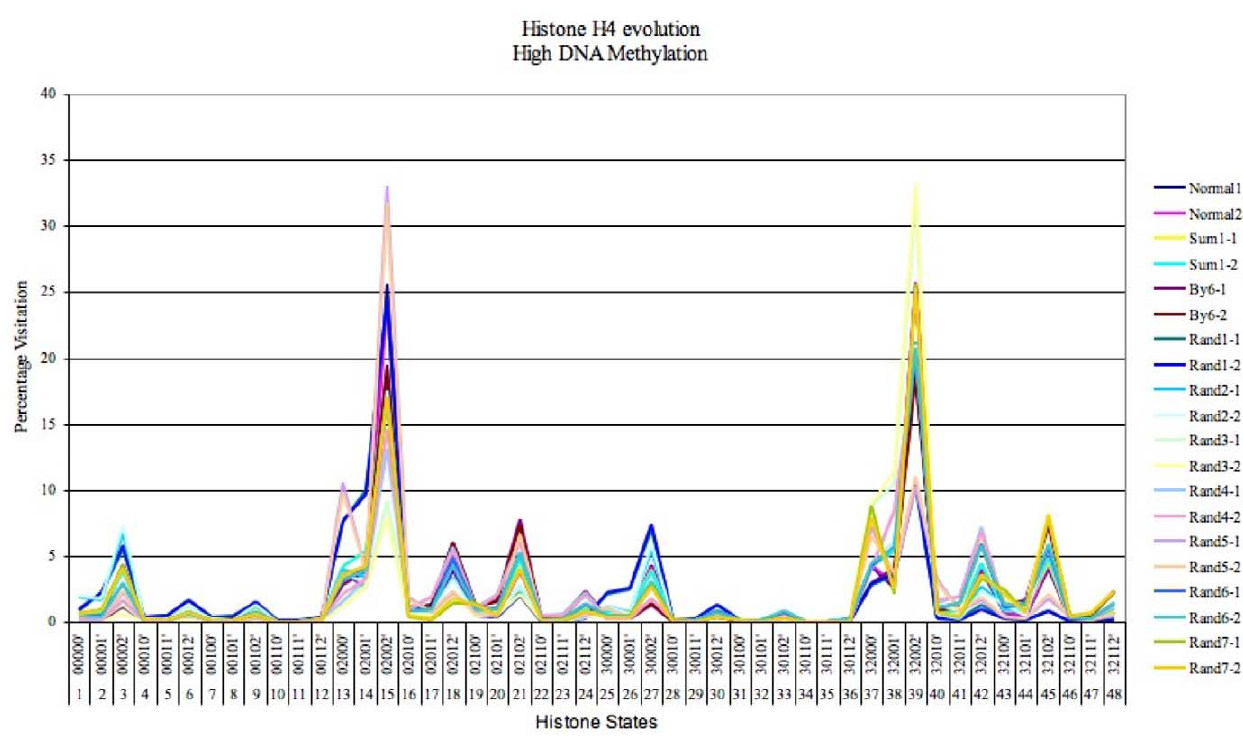
Figure 8. Evolution of H4 (H4-1 and H4-2) histone states in the 16 promoters for 10 different datasets during high DNA methylation levels ( , 0.85 or 85%). H4-1 and H4-2 histone states were tested with 10 dataset of random probability values (represented by colors in the graph).